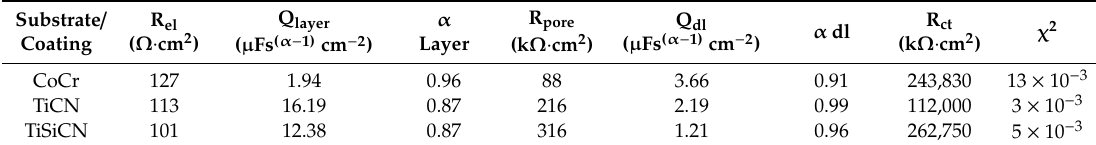
Table 5. The fitting results of EIS curves for the investigated systems.